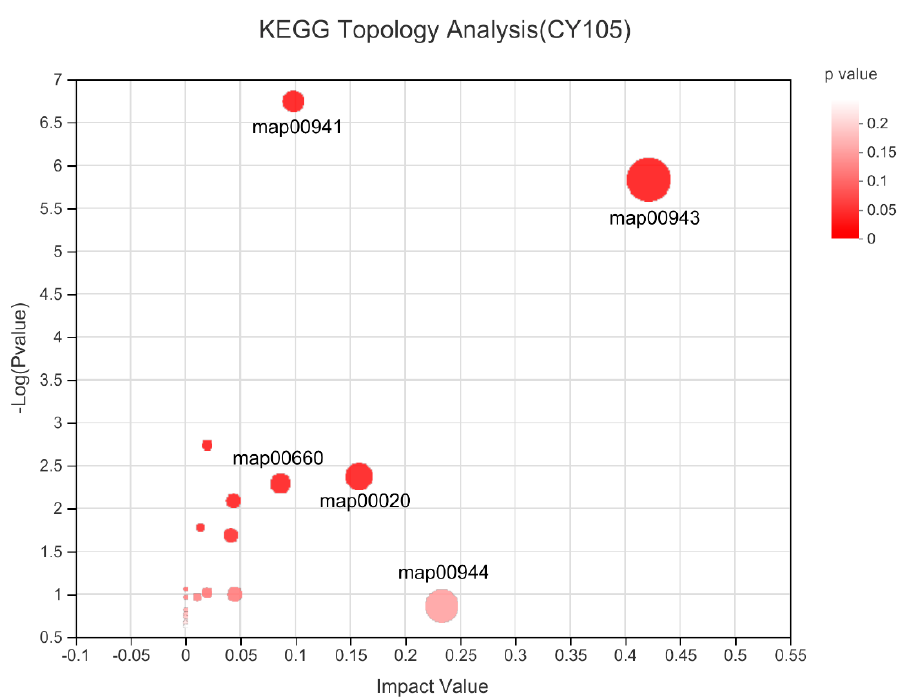
Figure 10. KEGG topology analysis of bubble graphs. Each bubble represents a KEGG pathway; the horizontal axis represents the relative importance impact value of metabolites in the pathway. The vertical axis represents the enrichment significance of the metabolite pathway -log10 ( p -value).